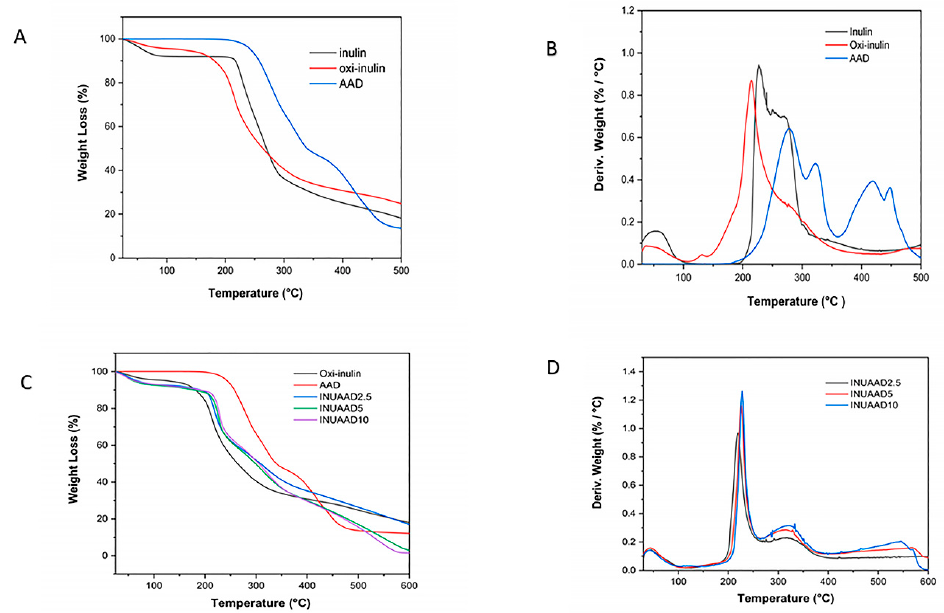
Figure 4. ( A ) Thermograms of the raw inulin, oxidized inulin, and AAD. ( B ) DTG thermograms of the raw inulin, oxidized inulin, and AAD. ( C ) Thermograms of the raw inulin, oxidized inulin, AAD, and hydrogels. ( D ) DTG thermograms of the hydrogels.